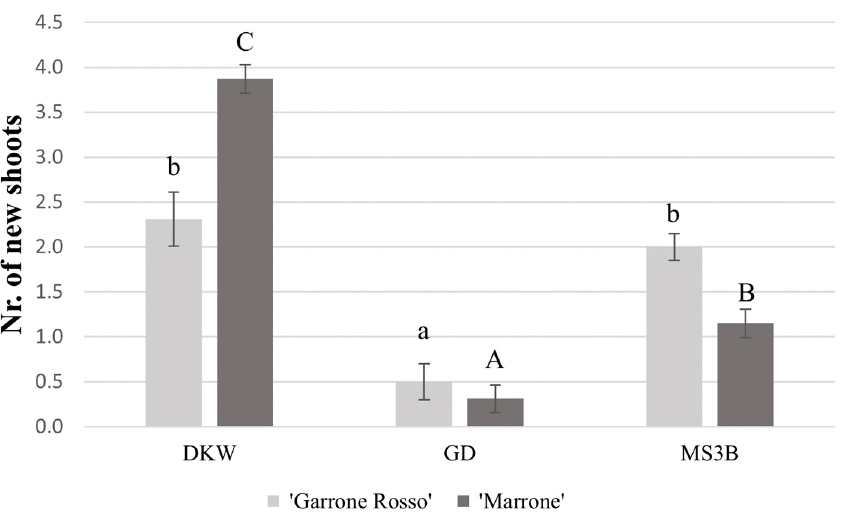
Figure 5. Histogram showing the multiplication rates of ‘Marrone di Castel del Rio’ and ‘Garrone Rosso’ cultivars. For each cultivar, means with the same letter do not significantly differ at p ≤ 0.05 (Tukey’s HSD test). Lowercase letters and capital letters were used for ‘Garrone Rosso’ and ‘Marrone di Castel del Rio’ respectively.